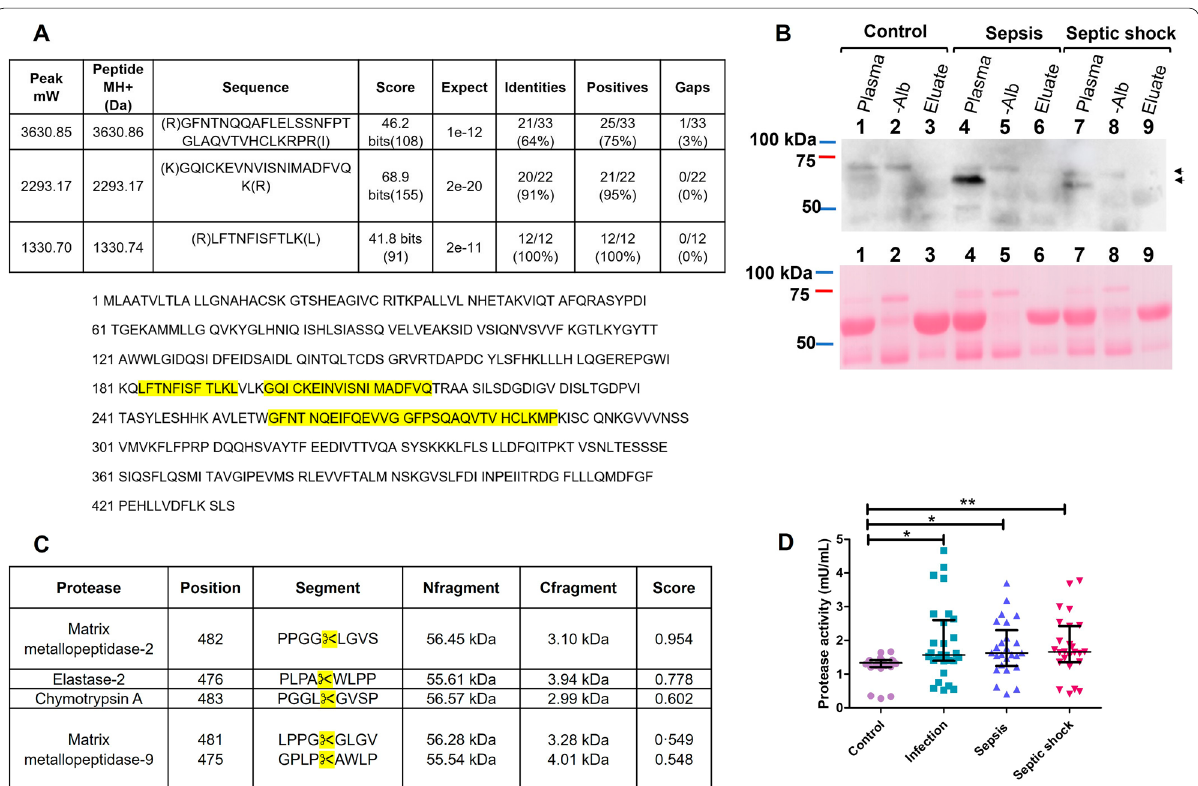
Fig. 6 Analysis of the 69 kDa and 67 kDa bands identified by western blotting that correspond to CETPI and peptides derived from its C‑terminal sequence. A Alignment parameters of peptides identified by HPLC‑mass spectrometry contained in the 69 kDa CETPI band employing Homo sapiens CETP sequences (GenBank: AAV38867.1). Peptides identified by HPLC‑mass spectrometry are highlighted in the CETP sequence. B Top: Immunodetection of CETPI in plasmas isolated from control subjects and patients before and after albumin depletion. Down: Same membrane stained with Ponceau S. Control plasma samples (lanes 1–3). Plasma samples from sepsis patient (lanes 4–6). Plasma samples from septic shock patient (lanes 7–9). Albumin‑depleted plasma samples (lanes 2, 5, 8). Albumin fraction recovered after elution of plasmas through the column (lanes 3, 6, 9). C Protease activity prediction upon the C‑terminal domain of CETPI employing Procleave (Li et al. 2020), ✂ indicates predicted cleaved sites. D Protease activity of plasmas obtained from control subjects